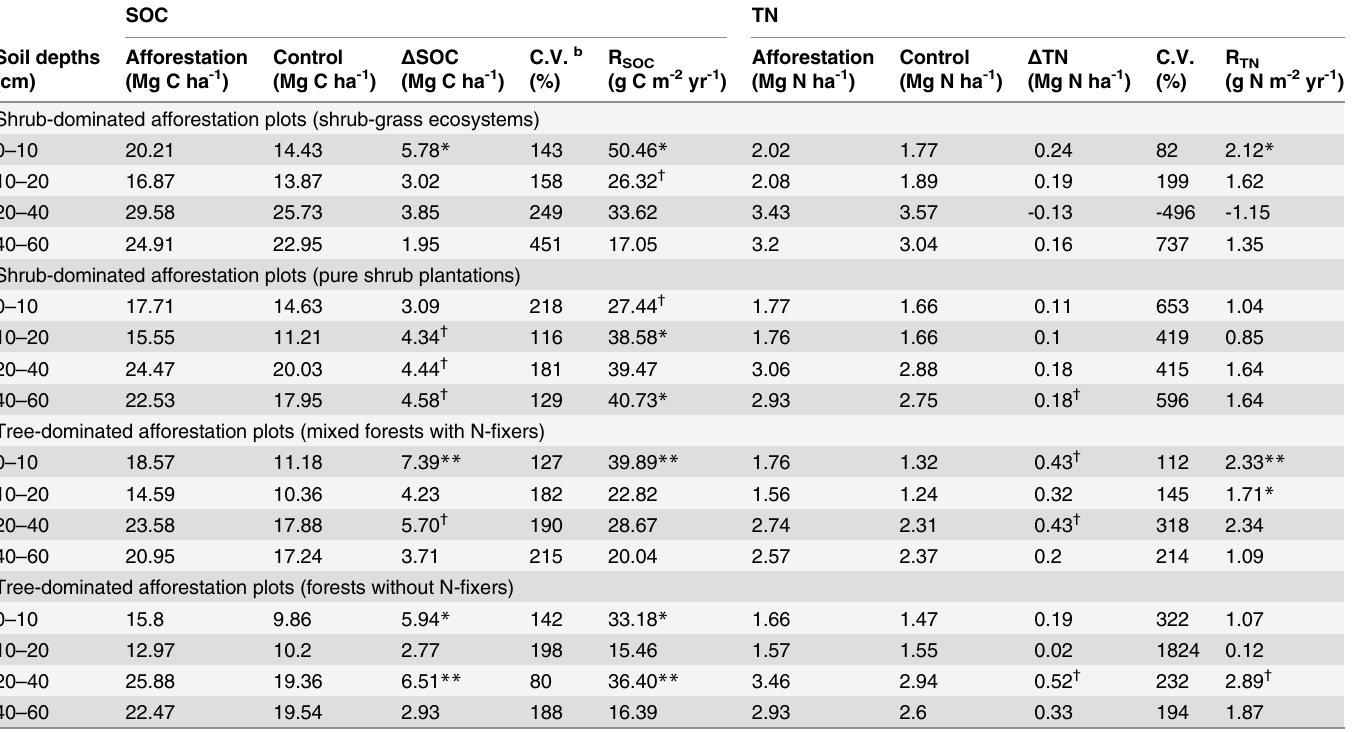
Table 1. SOC and TN contents and their changes after afforestation with shrubs and trees on the Qinghai Plateau. a